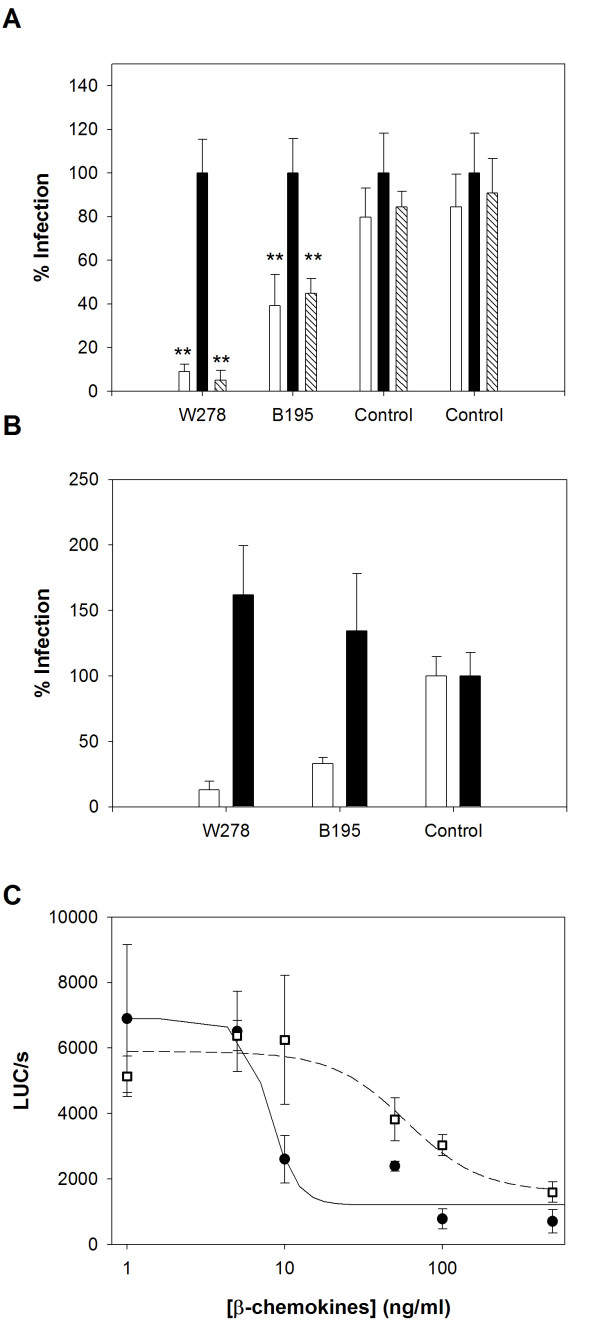
Role of β-chemokines in HIV-1 restriction in CD4 T cells from subjects W278 and B195. A. CD4 T cells from subjects W278 and B195 were challenged with the HIV-BaL pseudotype in the absence (white bars) or presence of a combination of neutralizing anti-RANTES (5 μg/ml), anti-MIP1α (15 μg/ml) and anti-MIP1β (25 μg/ml) (R&D systems, France) mAbs (black bars) or with an isotype control antibody (45 μg/ml) (patterned bars). The antibodies were added 30 minutes before challenge and maintained throughout the time course of infection. Results are expressed as relative luciferase activity, compared to the maximal activity found in the presence of the neutralizing anti-β-chemokines in each case, and are the mean of three independent infections ± standard deviation. ** Significant difference (P < 0.001 and P = 0.008 for W278 and B195, respectively, independent sample t-test). B. Challenge with the HIV-BaL pseudotype (n = 3, mean ± SD) of CD4 T cells from EUs W278 and B195, stimulated with PHA three days before (white bars) or two hours after (black bars) challenge. Luciferase activity in cell lysates from a representative control challenged in the same conditions was attributed a value of 100%. C. Sensitivity of CD4 T cells to recombinant chemokines. Non mitogen-stimulated CD4 T cells from EU B195 (filled circles) and one control (open squares) were exposed to various concentrations of a mixture of the recombinant β-chemokines RANTES, MIP-1α and MIP-1β (R&D systems, France) for 30 minutes prior to and during infection. The mixtures contained the three chemokines at concentrations ranging from 500 ng to 2 ng each. Results (n = 3, mean ± SD) are expressed as luciferase activity per second in cell lysates. Points were fitted to a four-parameter logistic curve (r2 were 0.845 and 0.826 for B195 and control, respectively). Statistical analysis and curve-fitting were performed with Sigmaplot software (Systat Software, Inc, CA, USA).